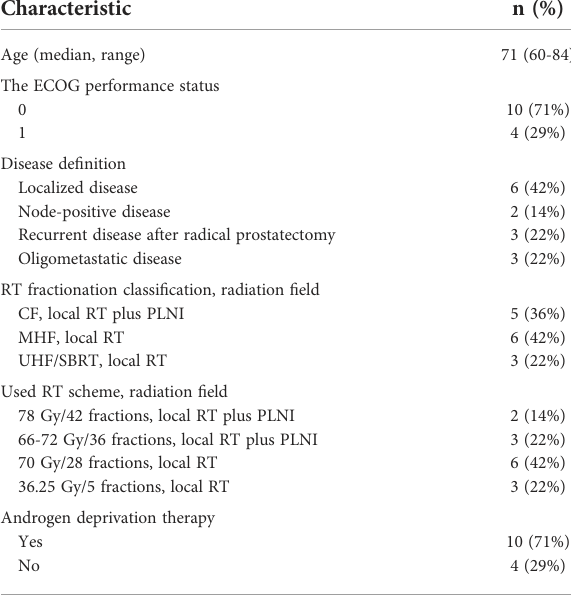
TABLE 1 Patient and treatment characteristics.